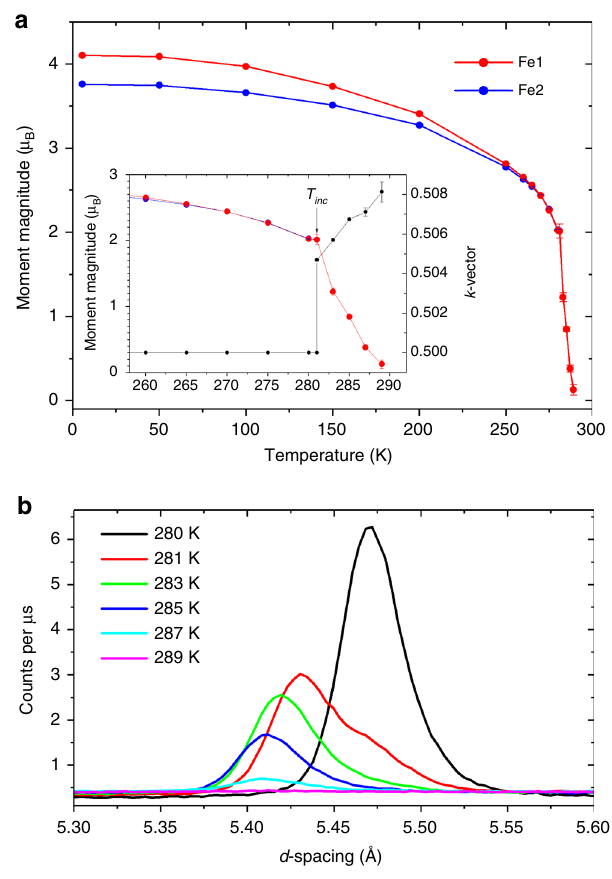
Fig. 7 Temperature dependence of the magnetic ordering in CaFe 3 O 5 . a Ordered magnetic moment of the Fe1 and Fe2 sites in CaFe 3 O 5 versus temperature from Rietveld re fi nement of the magnetic structure against neutron diffraction data. The inset of a shows the same data in the 260 – 290 K range alongside the magnetic ordering vector k , which becomes incommensurate at 281 K. b Evolution of the (½ 0 1) peak at 280 K collected on the 90° bank of the WISH diffractometer 23 is shown on warming through the commensurate-to-incommensurate transition (see also Supplementary Fig. 4). a axis, described in the Cmcm1 ’ ( α 00)00ss magnetic superspace group, corresponding to the m Σ 3 irreducible representation with order parameter direction ( ξ , 0). At 283 K the separately re fi ned amplitudes of the spin density wave are 1.98(4) and 2.08(3) µ B for the Fe1 and Fe2 sites, respectively. Given that the difference between the Fe1 and Fe2 SDW amplitudes is within 2 σ and the re fi ned moments in the commensurate region converge on warming, both sites were constrained to have the same SDW amplitude in the incommensurate region, (re fi ned value of 2.02 (2) μ B ). The phase coexistence between the commensurate and incommensurate phase that is observed at 281 K is expected since the lock-in character of the transition (see below) requires it to be fi rst order. At 281 K the model has 55% of the and 45% of the commensurate phase with propagation vector (½ 0 0), assuming both phases have the same average moment. The incommensurate-regime is only adopted in a narrow temperature range, with a monotonic increase of the k -vector with increasing temperature to a maximum of α = 0.507(2) at 287 K before the moment falls to zero within error on warming to 289 K. The narrow temperature range for this incommensurate region